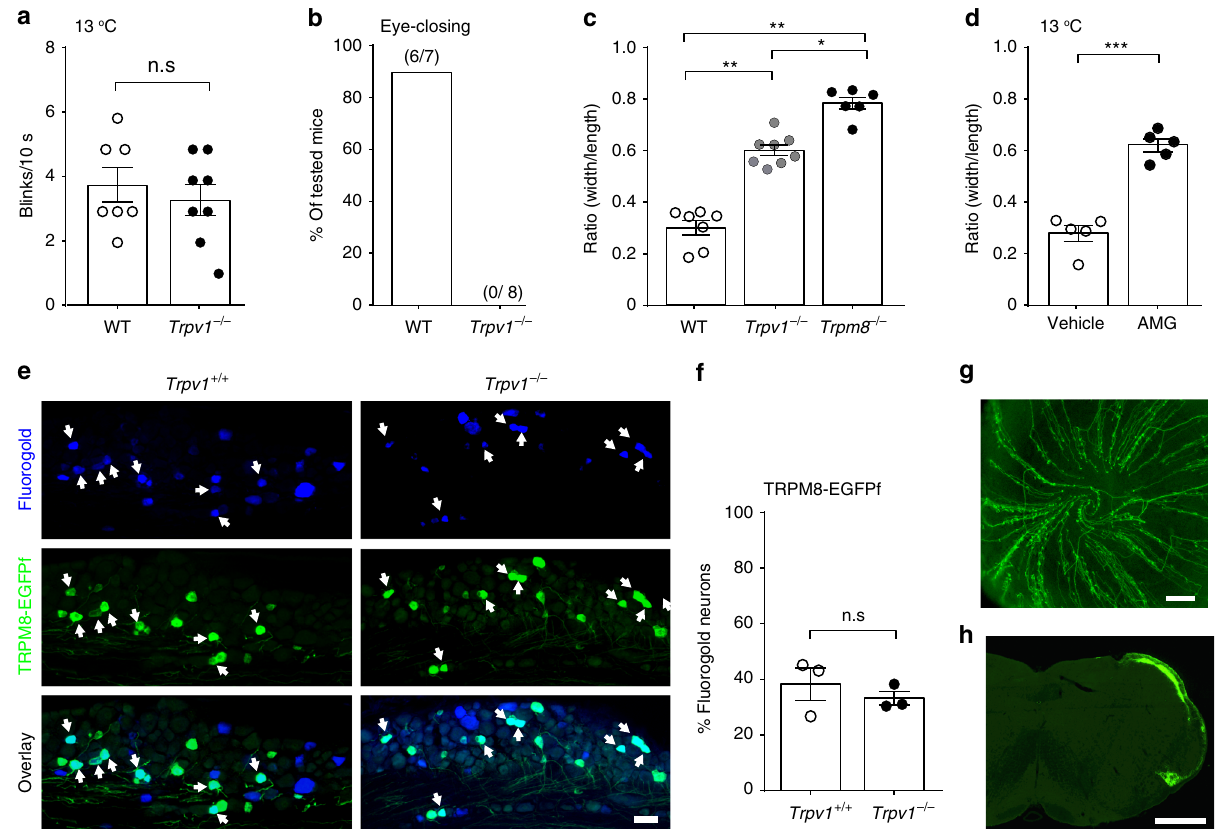
Fig. 4 TRPV1 is required for ocular cold nociception. a , b Although the re fl ex blinking response to cold was not altered in Trpv1 − / − mice ( n = 8), their eye closing responses were eliminated, compared with WT controls ( n = 7). c The ocular width/length ratio of Trpv1 − / − mice ( n = 8) in response to cold (13°C) was signi fi cantly greater than that of WT mice ( n = 7), but lower than that of Trpm8 − / − mice ( n = 6). d The ocular width/length ratio in response